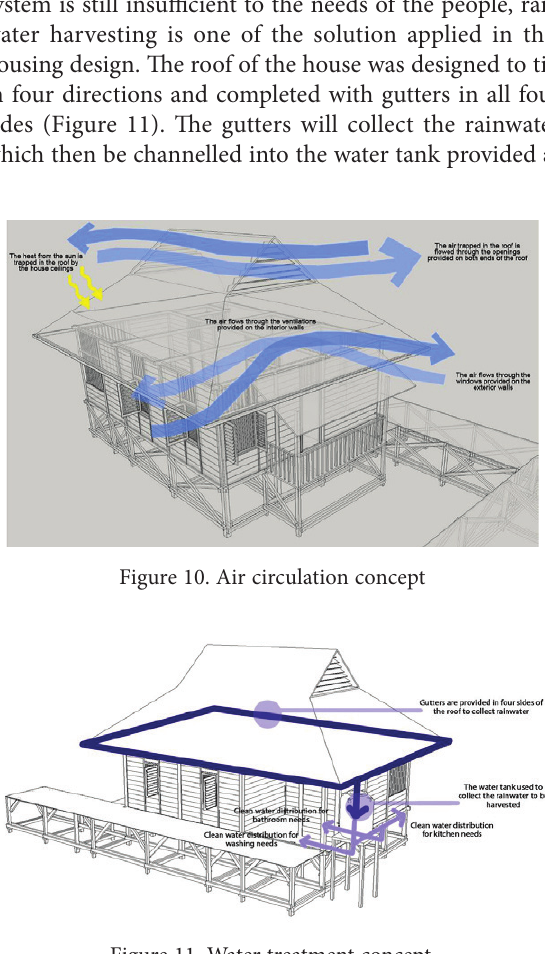
Figure 11. Water treatment